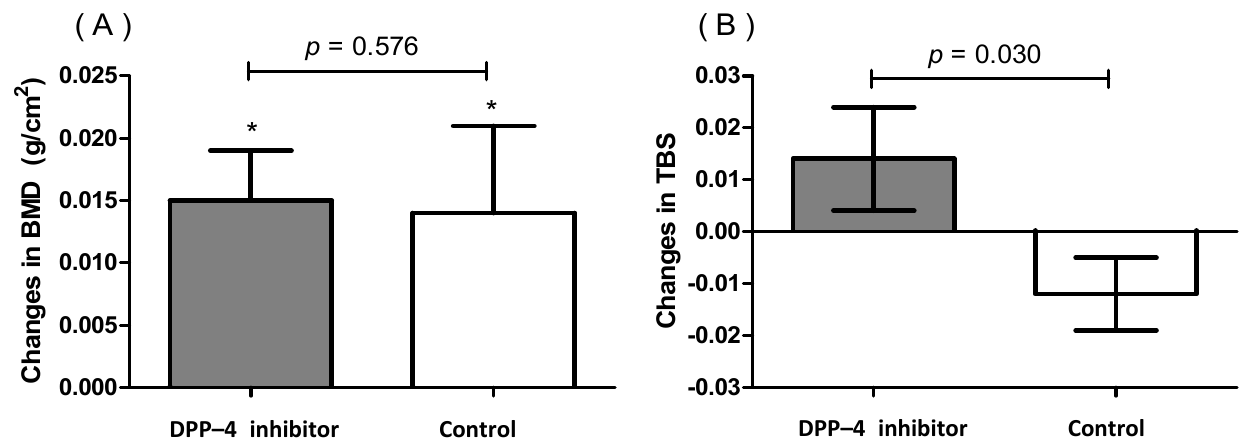
Figure 1. Changes in ( A ) the BMD and ( B ) TBS during the follow-up period after the DPP-4 inhibitor treatment. Data are expressed as the mean ± SE. * p < 0.05 by the paired t- test between the values recorded at the baseline and follow-up. p -values were calculated using the Student’s t -test for changes between the two groups.